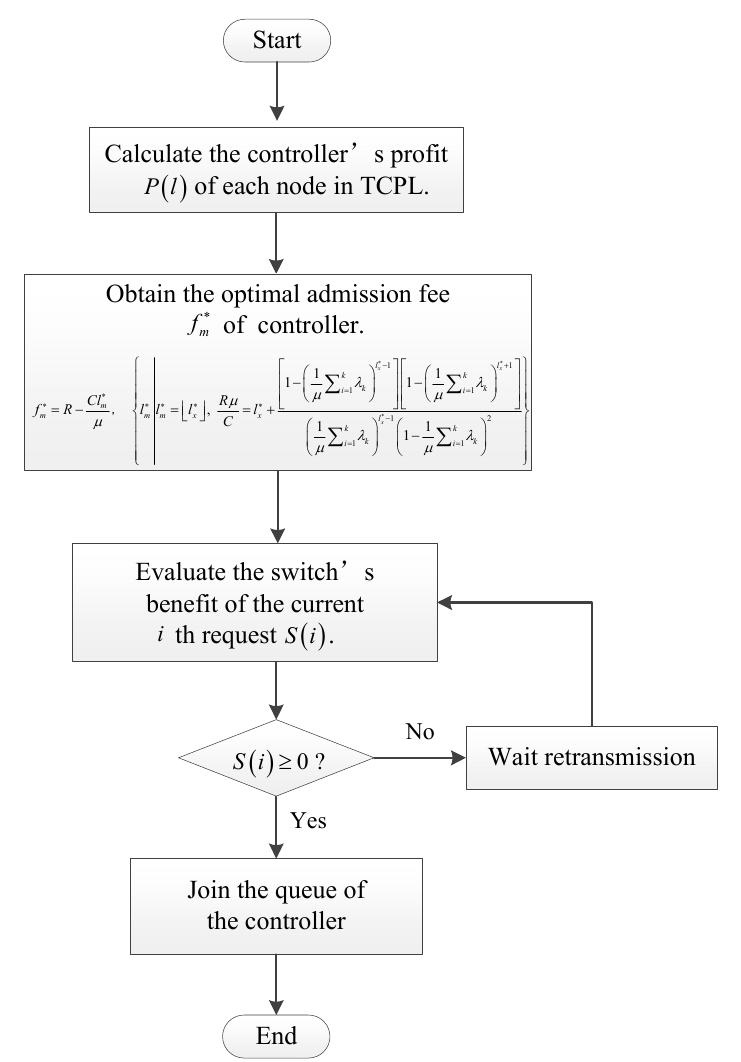
Figure 2. The flow chart of the TCQG